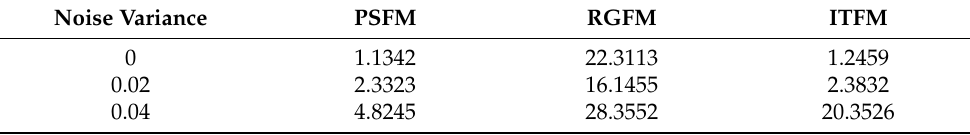
Table 1. MSE of the reconstructed phases for automatic spatial filtering